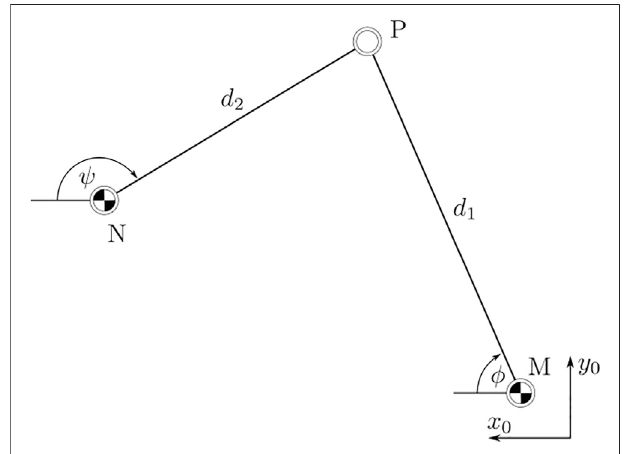
Frontiers in Robotics and AI |